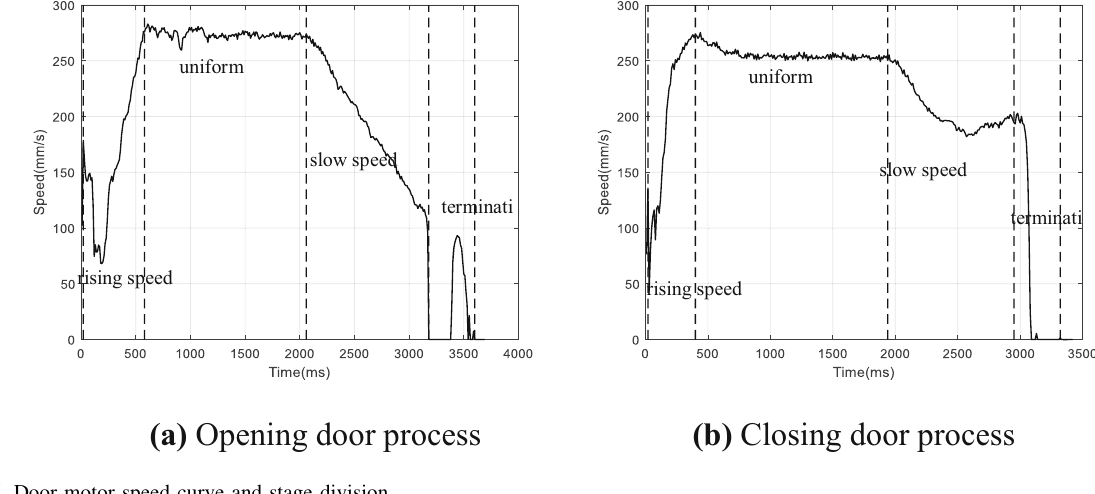
Fig. 5 Door motor speed curve and stage